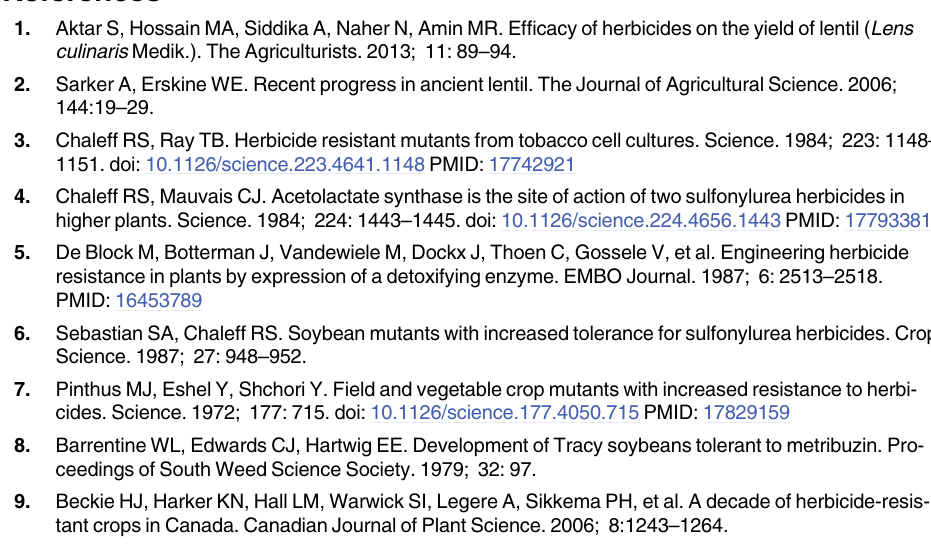
S1 Table. SAS code for data analysis under ASSPED (Example S1 Table survival percentage response). S2 Table. Responses for the ASSPED. S3 Table. Field reaction of M populations against 2